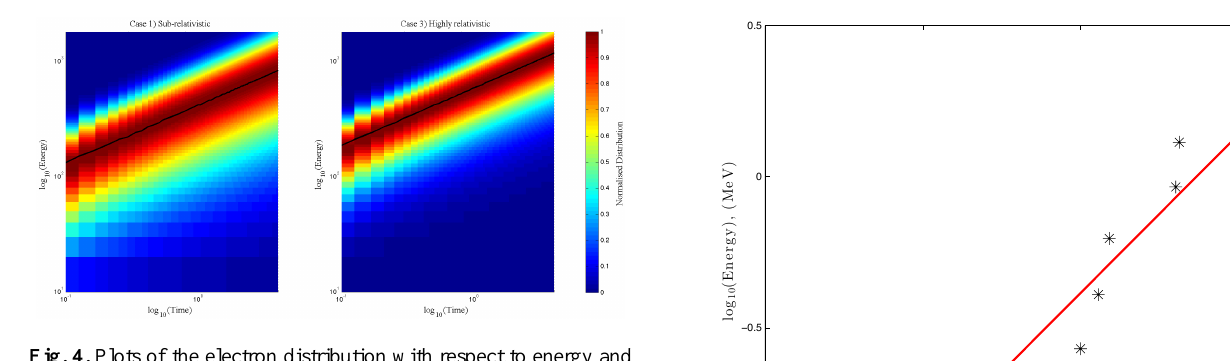
Fig. 4. Plots of the electron distribution with respect to energy and time from Eqs. (17) and (18), normalised between 0 and 1 for each time bin.